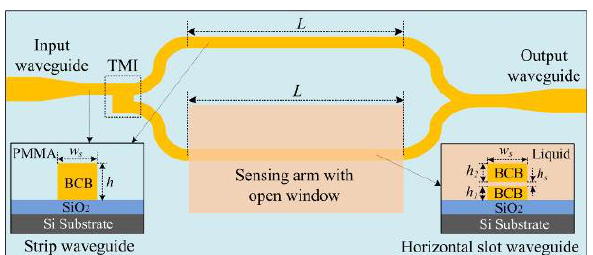
Fig. 4. Schematic diagram of the MZI sensor employing a polymer horizontal slot waveguide in one arm as light-analyte interactive region. Inset: cross-sectional view of the conventional strip waveguide (left) and the horizontal slot waveguide (right).